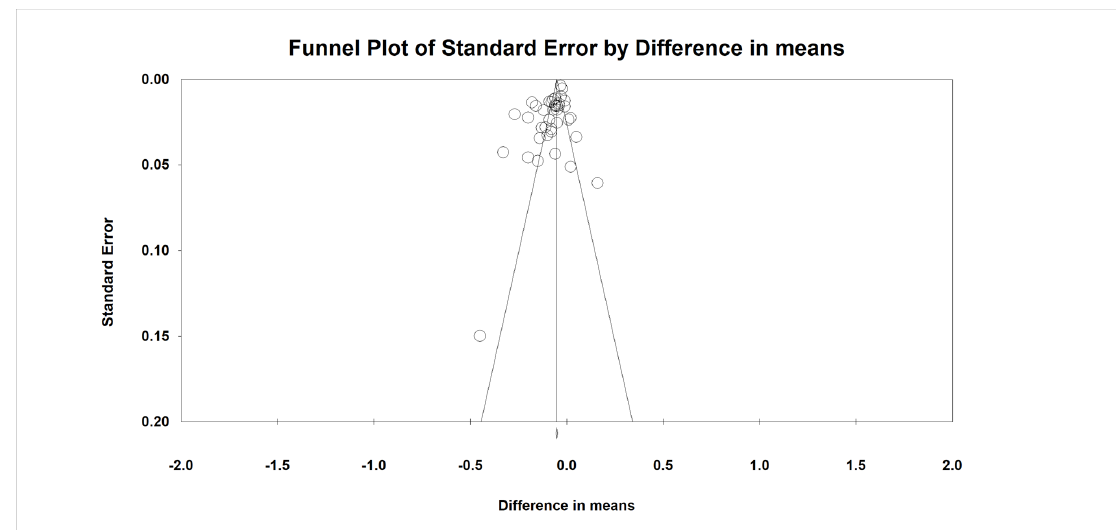
Figure 5. Funnel plot of standard error by difference in means.